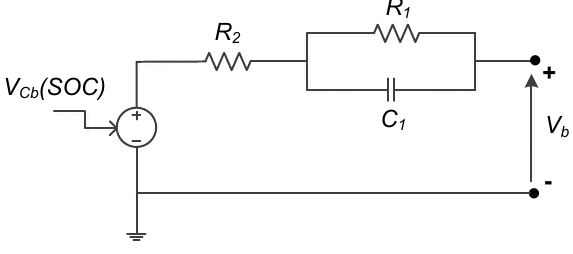
Figure 3. Simplified circuit battery model.